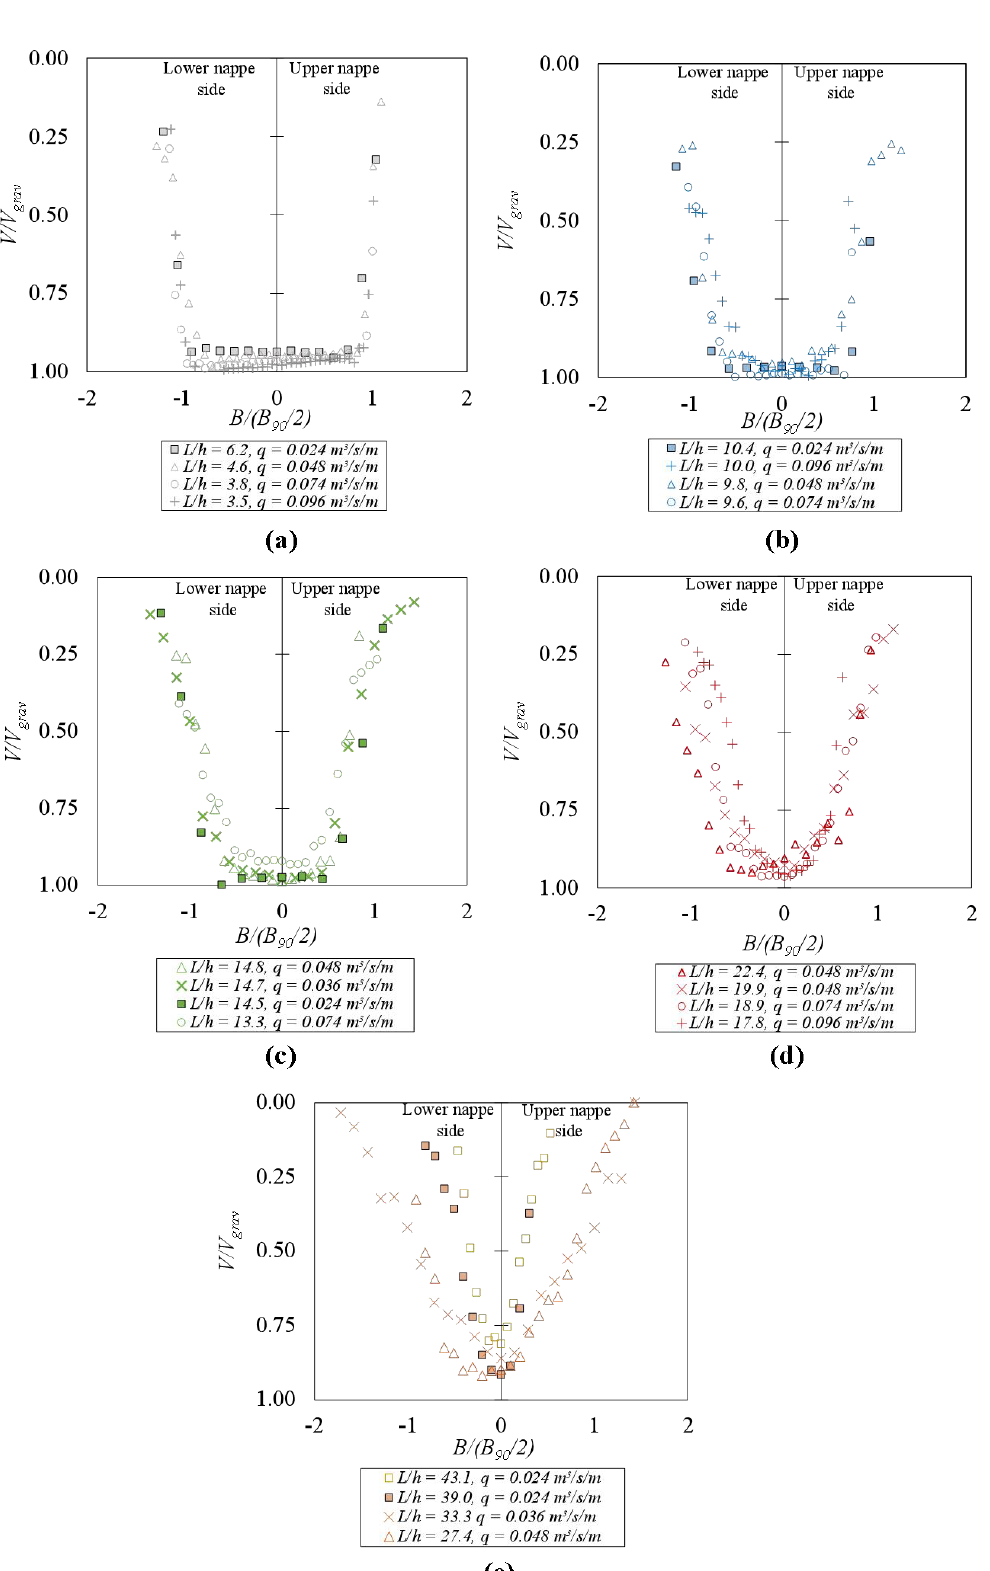
Figure 11. Dimensionless velocity distribution V/V max through the rectangular free-falling jet: ( a ) L/h ratio between 3.5 and 6.2; ( b ) L/h ratio between 9.6 and 10.4; ( c ) L/h ratio between 13.3 and 14.8; ( d ) L/h ratio between 17.8 and 22.4; ( e ) L/h ratio between 27.4 and 43.1.